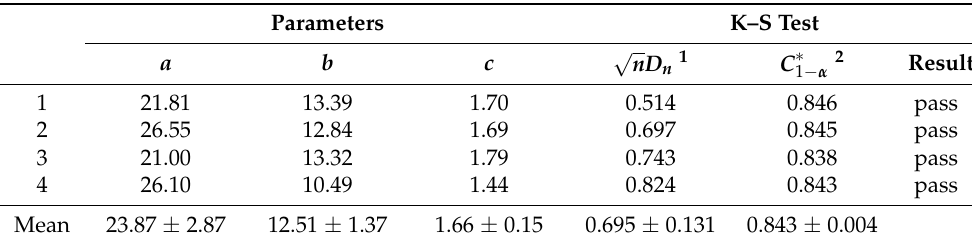
Table 3. The parameters of the Weibull function are predicted by the least squared estimator and the result of the Kolmogorov–Smirnov (K–S) test. Parameters